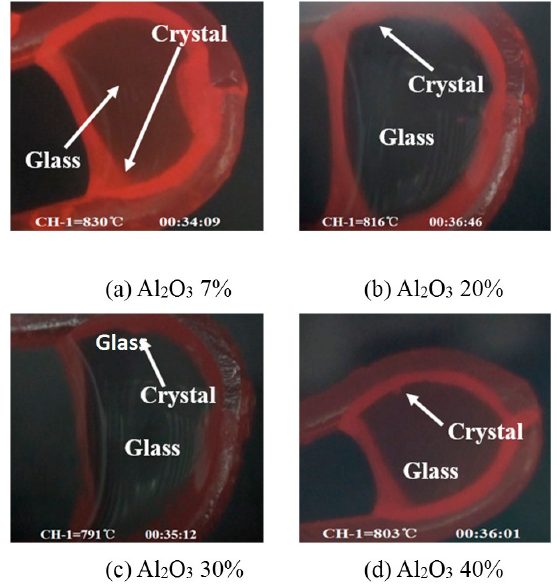
Figure 15. The glassy/crystalline transition temperature of mold fluxes with different amounts of Al 2 O 3 . Table 2. Conditions for R int calculations of mold fluxes with different amounts of Al 2 O 3 .